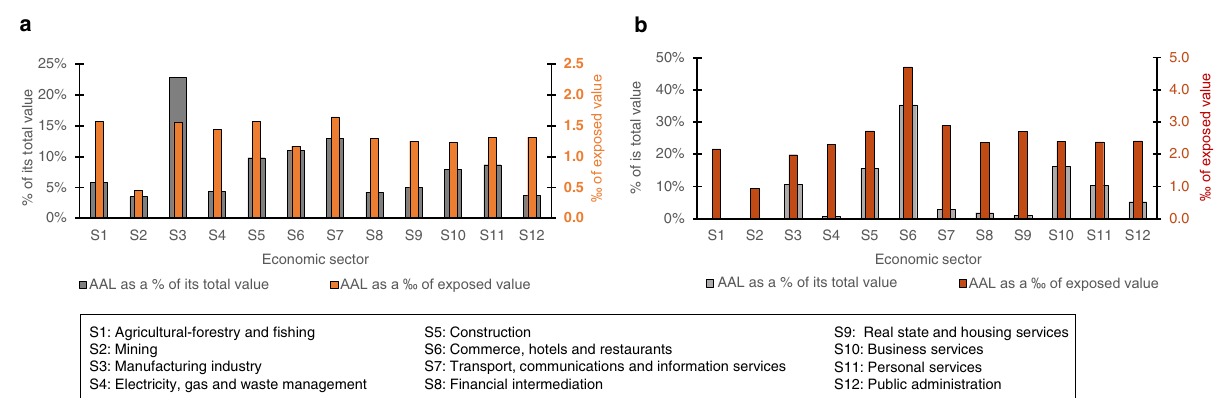
Fig. 2 Average Annual Loss (AAL) for Chile by economic sector. a Shows the production AAL as a percentage of its total value (gray) and as a fraction (per thousand) of its yearly sectoral production (orange). b Shows the direct AAL as a percentage of its total value (gray) and as a fraction (per thousand) of the corresponding sectorial value of non-residential buildings (red). AAL is presented as a percentage of its corresponding total value to see the in fl uence of each sector in the total AAL and as a fraction (per thousand) of its corresponding exposed value to see how risky each sector is.